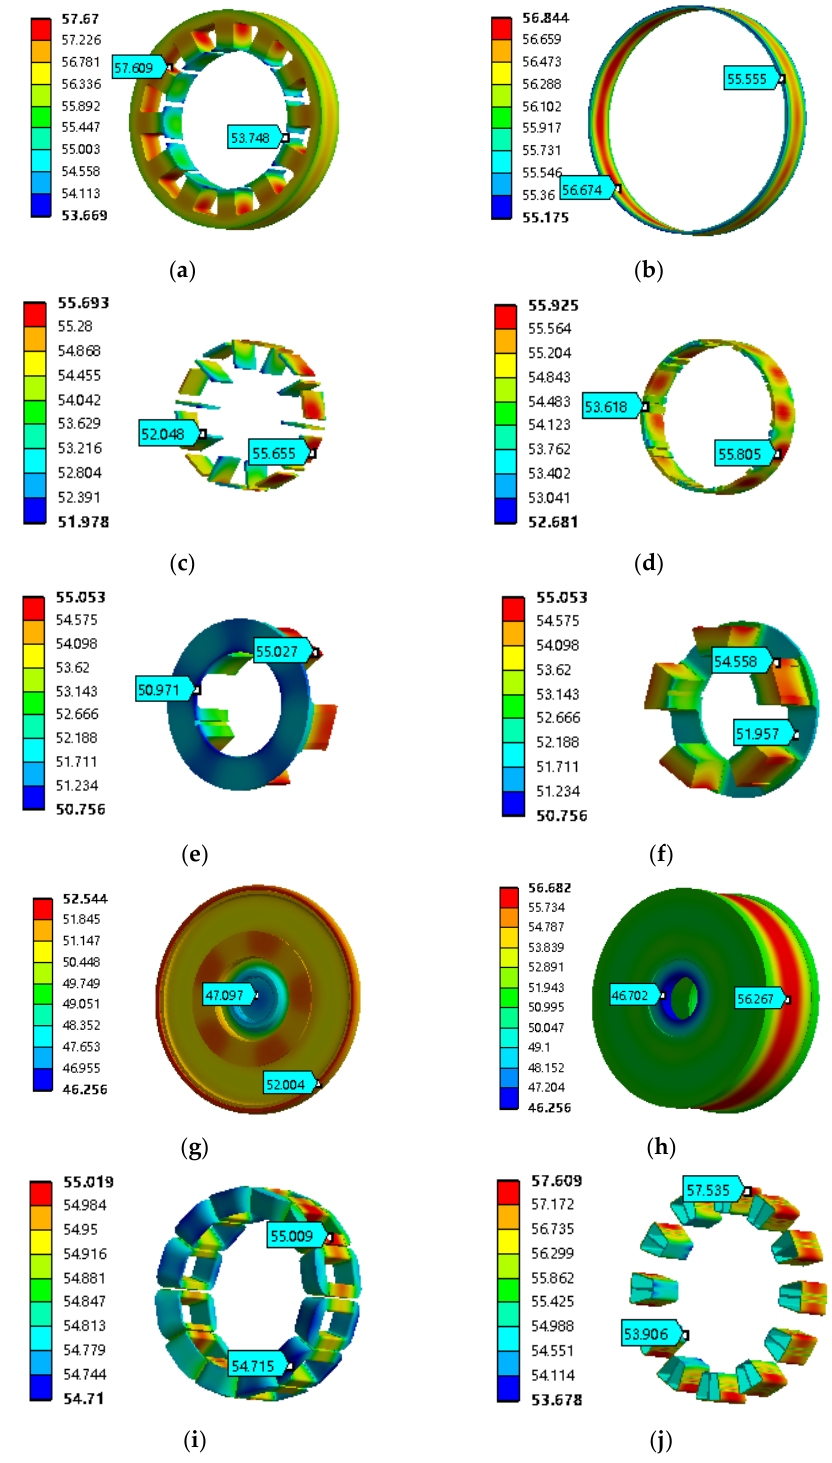
Figure 12. DHEG temperature distribution at 3000 rpm: ( a ) Stator; ( b ) Nonmagnetic ring; ( c ) PM; ( d ) Rotor yoke; ( e ) Claw pole I; ( f ) Claw pole II; ( g ) Magnetic bridge; ( h ) Enclosure; ( i ) Armature winding; ( j ) Insulation.